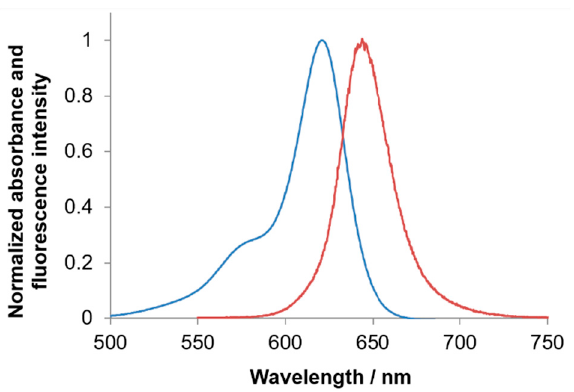
Figure 2. Absorption (blue line) and fluorescence (red line) spectra ( λ ex = 621 nm) of BRhoC (8.7 μ M) in a 10 mM HEPES buffer at pH 7.4.